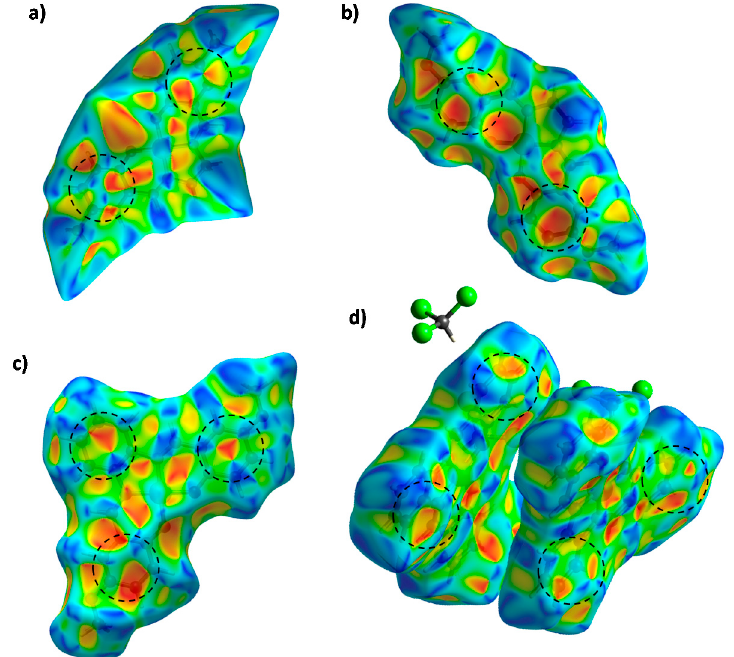
Figure 10. HS of the compounds NiMe salen ( a ), NiMeO salen ( b ), NiMeO salphen ( c ), and Ni salphen ( d ), mapped with shape index.